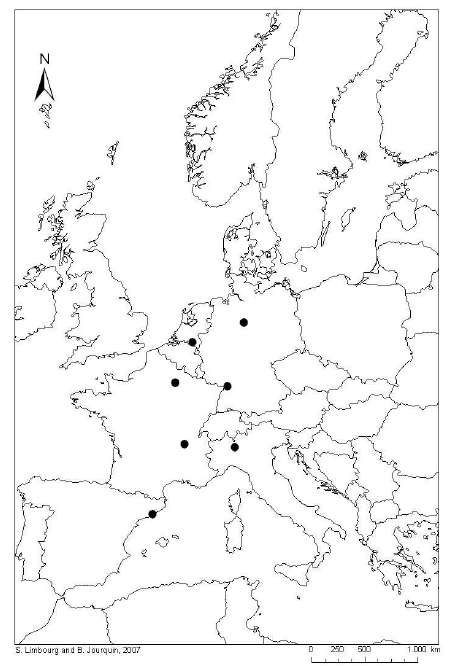
Figure 14. The 7 hubs obtained using data corresponding to the selected potential locations.